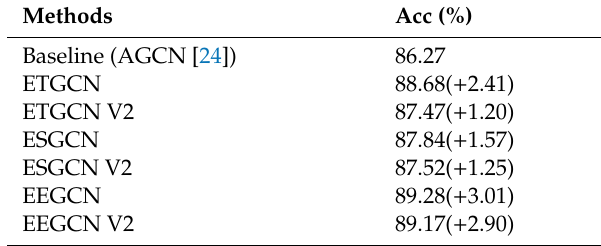
Table 2. Action recognition accuracies by the various variants of our proposed